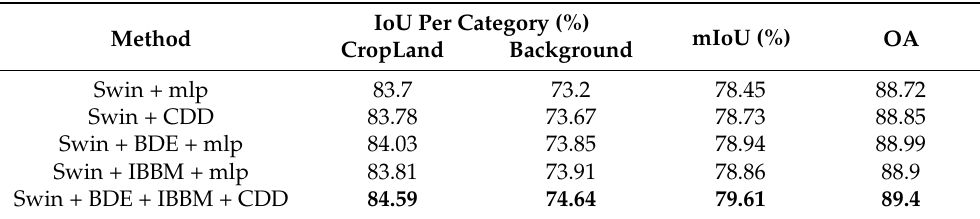
Table 3. The ablation experiments on the Agriculture dataset evaluated by mIoU (%) and OA (%) about the methods. We employed the overall accuracy (OA), Intersection over Union (IoU) of Per Category and the mean Intersection over Union (mIoU) to evaluate model performance.